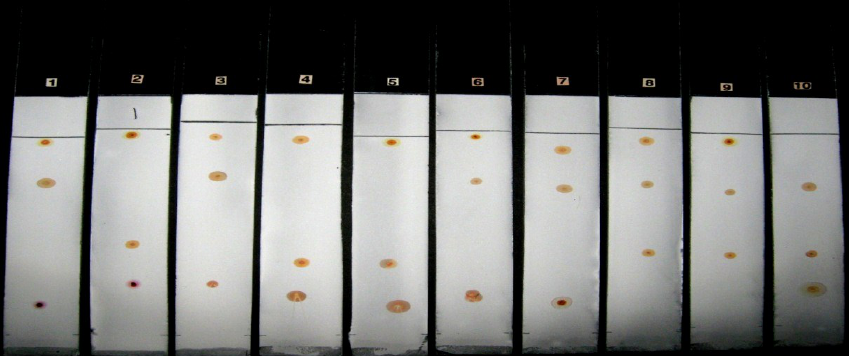
Picture No 2. Ternary Separations.